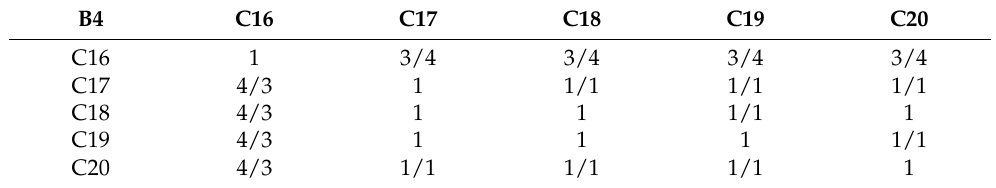
Table A8. B4-C judgment